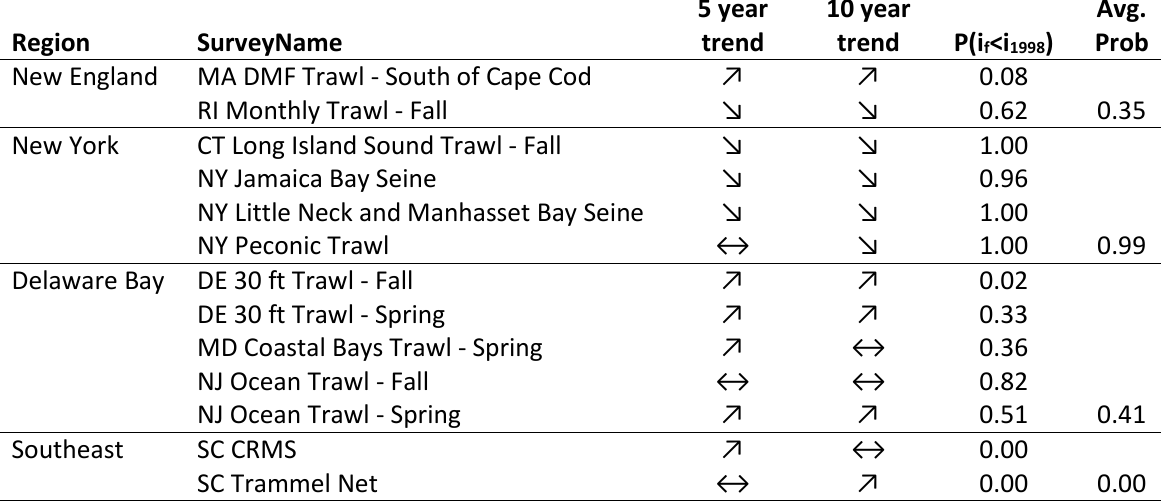
Table 54. Details of surveys used in determining regional stock status. Arrows indicate increasing (↗), decreasing (↘), or stable (↔) trends over the most recent 5 and 10 year periods. P(i f <i 1998 ) represents the probability of the terminal year’s fitted index value (i f ) being less than the 1998 index-based reference point from ARIMA modeling. The average of this probabilities within a region is also